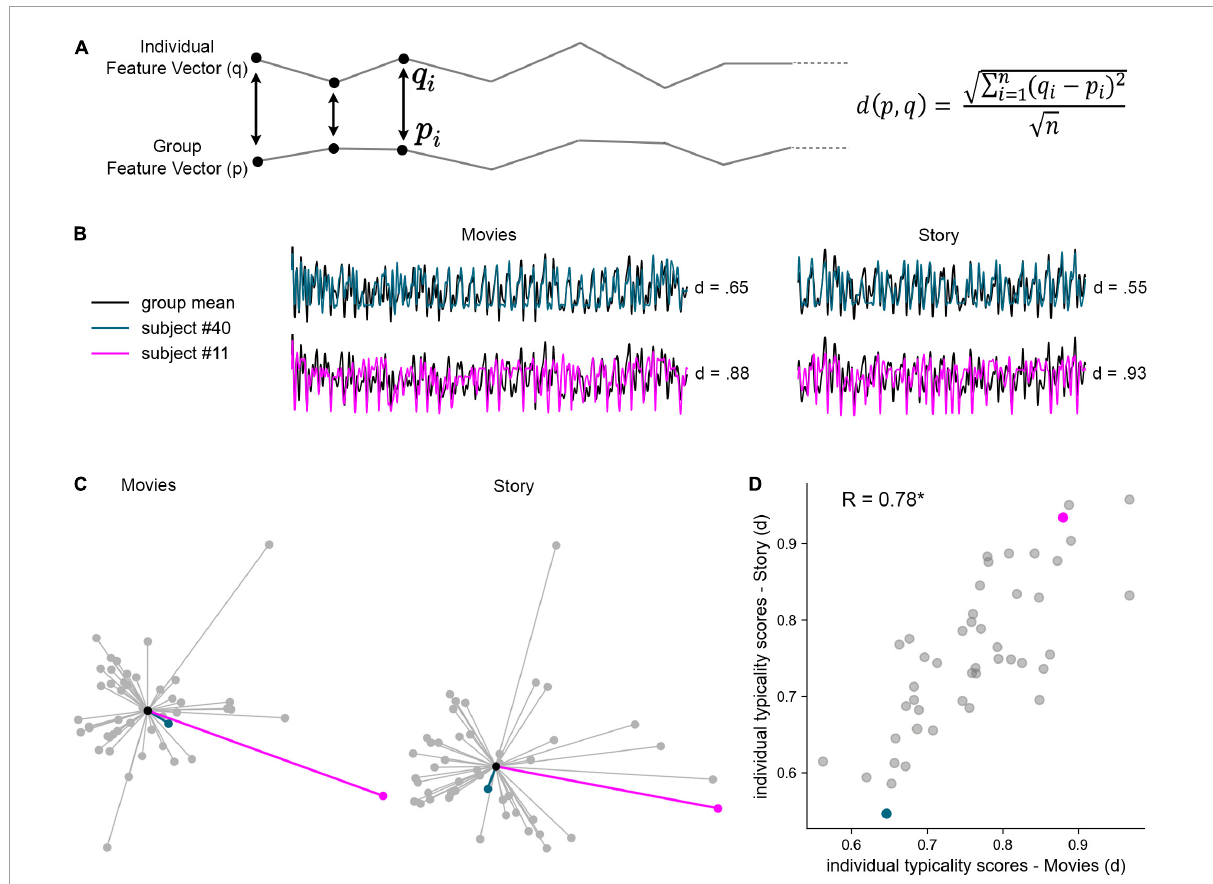
FIGURE5 Individual typicality of cognitive dynamics. (A) Individual typicality was measured by the Euclidean distance ( d ) between the feature vector of each participant ( q ) and that of the group ( p ), given by the square root of the sum of squared deltas for each element i of q and p between 1 and n . Euclidean distance was scaled by the square root of vector length. Individual typicality was separately measured across the 33 movie events and across the 22 story events, over eight cognitive measures (movies n = 264, story n = 176). Panels (B–D) illustrate the stability of individual typicality across movies and story, highlighting two example participants, #40 (cyan) and #11 (pink), relative to the group mean (black). (B) Rating dynamics of the two example participants overlaid on the z-scored group means, and their typicality indices. (C) Illustration of the distances between every participant and the group mean, under Isomap 2D dimensionality reduction. Each node represents a single participant and each edge represents the participant’s Euclidean distance from the group mean (center node). (D) Individual typicality scores, calculated in full dimensionality, were significantly correlated across subjects between movies (X axis) and story (Y axis). Each data point represents a single participant. * P <